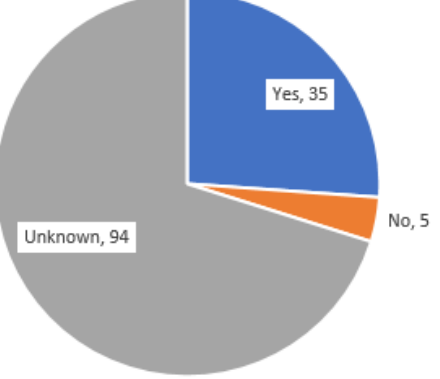
Fig. 2. The answers of 135 respondents to the question “Is the WPS function enabled in your private Wi-Fi network?”. Amount of times each answer has been picked is given after the